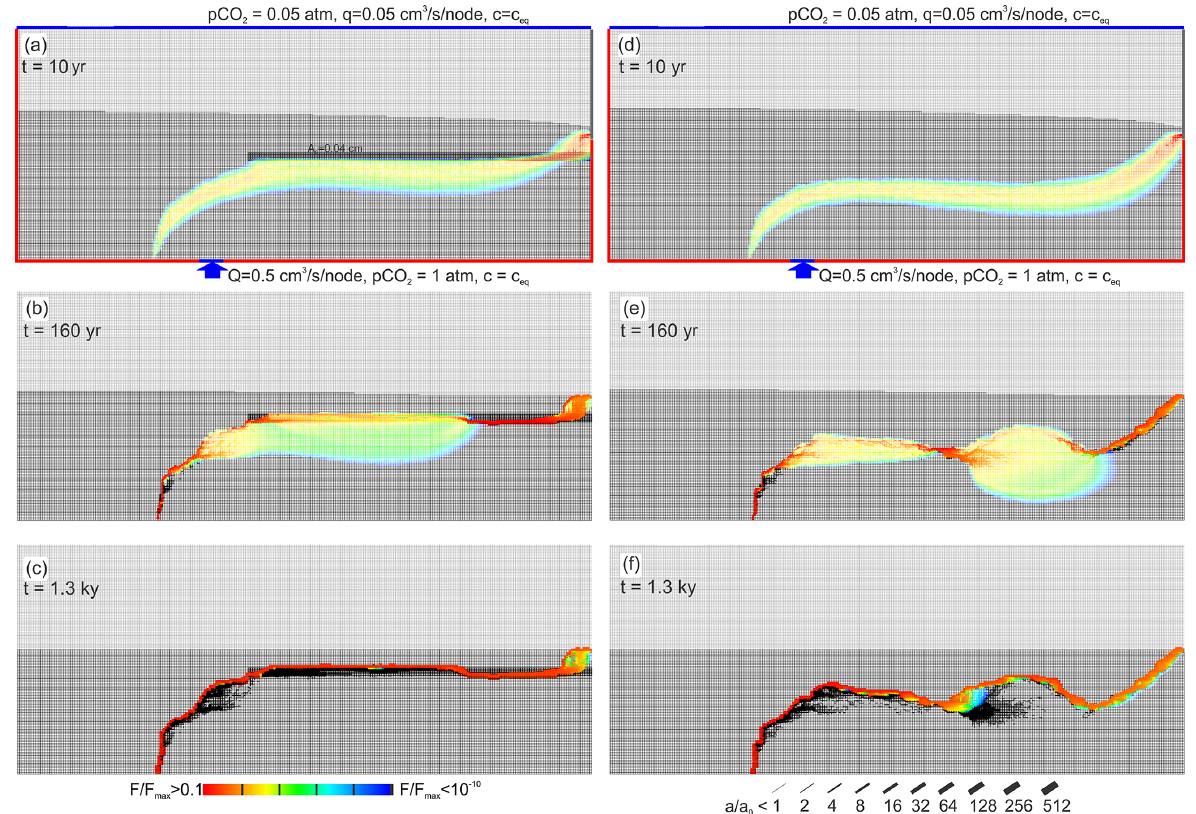
Figure 9. Evolution of the standard scenario with region fractures with larger initial aperture a 0 = 0 . 04 by black region (a–c) compared to the evolution of the standard scenario on the right-hand side (d–f) . The region of enlarged fractures dominates the evolution.